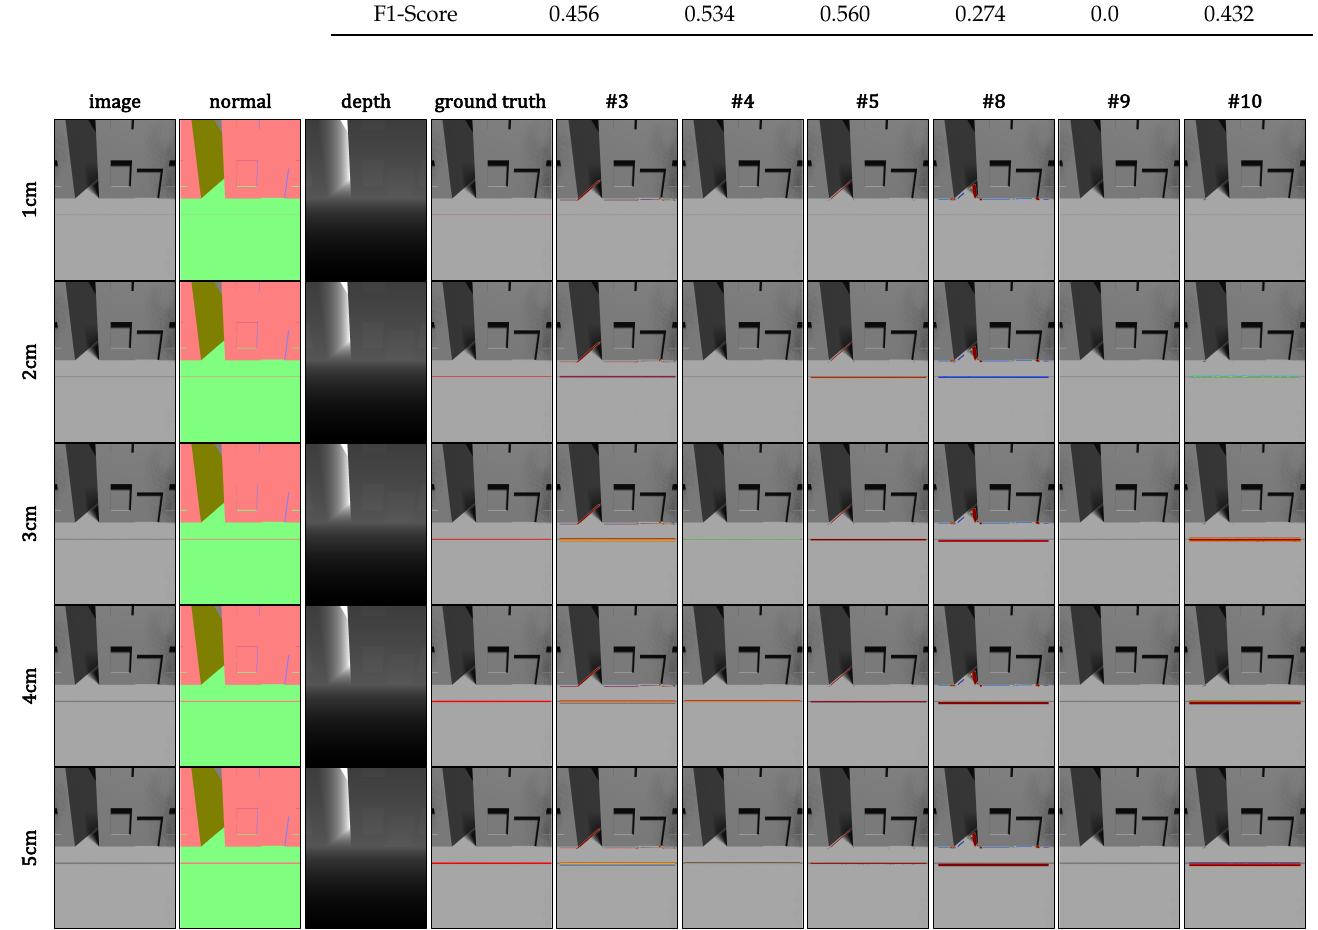
Figure 14. Results for synthetic test